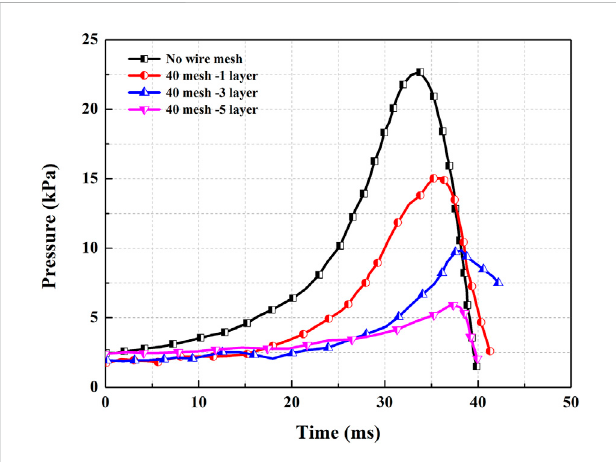
FIGURE 8 Flame explosion pressure under different wire mesh